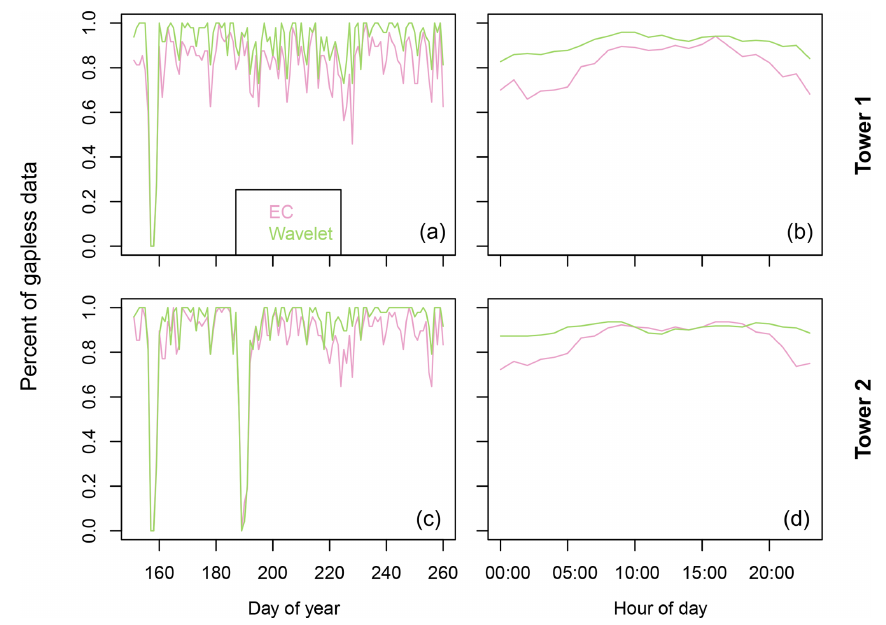
Figure A2. Seasonal (a, c) and diurnal (b, d) distribution of data availability for wavelet-derived (green lines) and EC-derived (pur- ple lines) methane